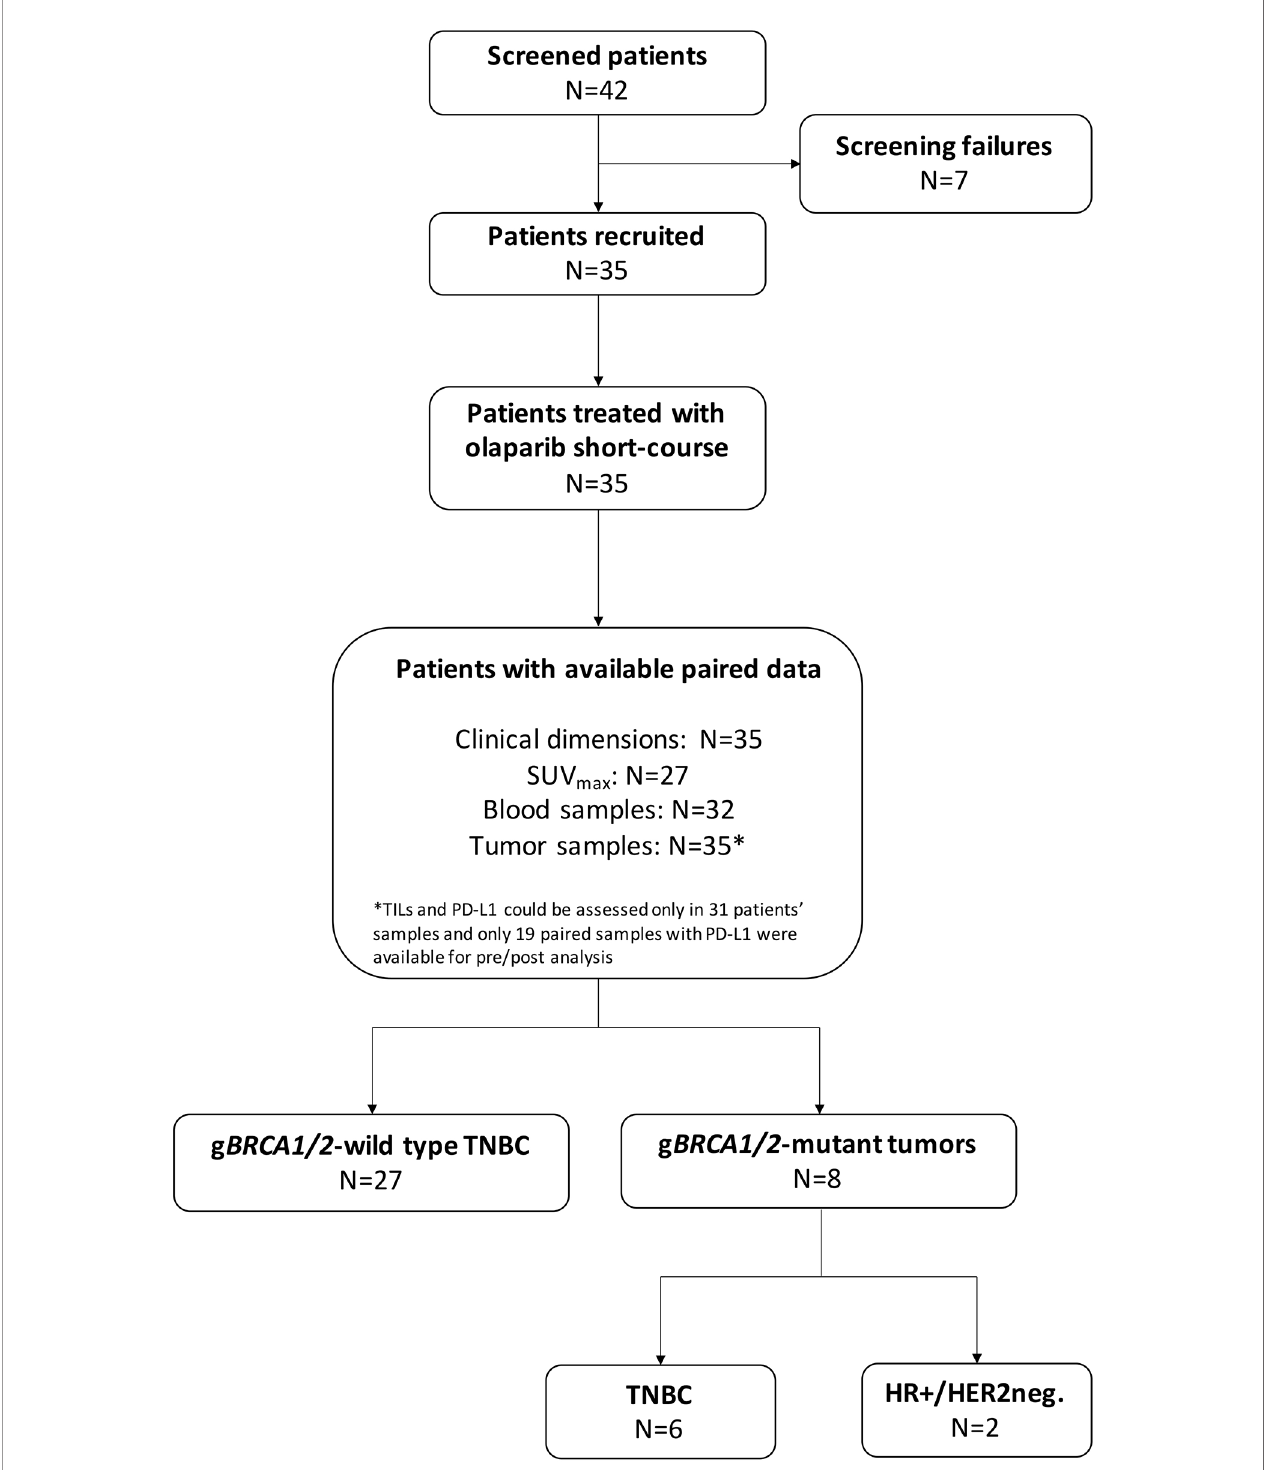
FIGURE 1 | CONSORT diagram. TNBC, triple negative breast cancer; HR+, hormone receptor-positive; HER2neg., HER2-negative; g BRCA1/2 , germline BRCA1 and BRCA2; SUV, standard uptake volume; TILs, tumor-in fi ltrating lymphocytes.